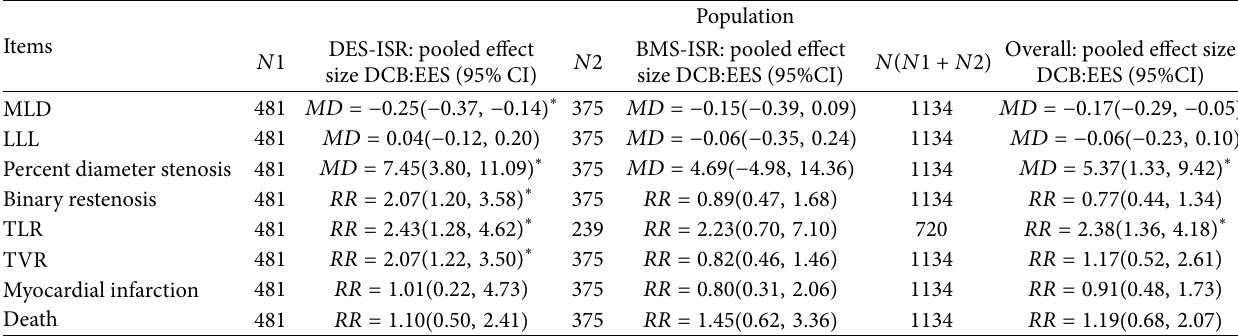
Figure 2: Mean difference in the percent diameter stenosis between the DCB and EES groups, and the risk of bias among included studies. Subgroup analysis was performed based on the type of restenosed stent. BMS, bare-metal stents; DES, drug-eluting stents; DCB, drug-coated balloons; EES, everolimus-eluting stents. Table 3: Summary of the main